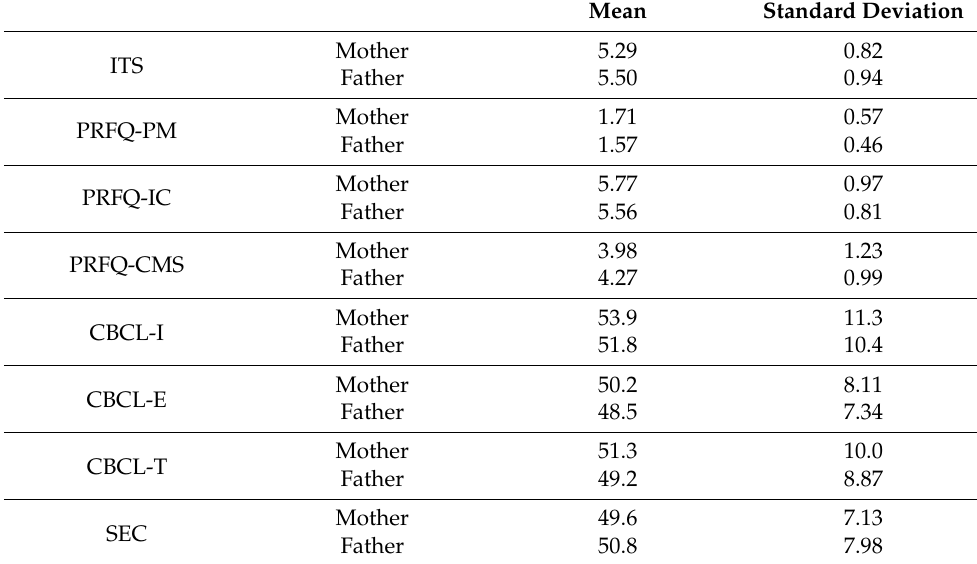
Table 2. Descriptive statistics of parental mentalizing, child’s psychological symptoms and child’s social–emotional